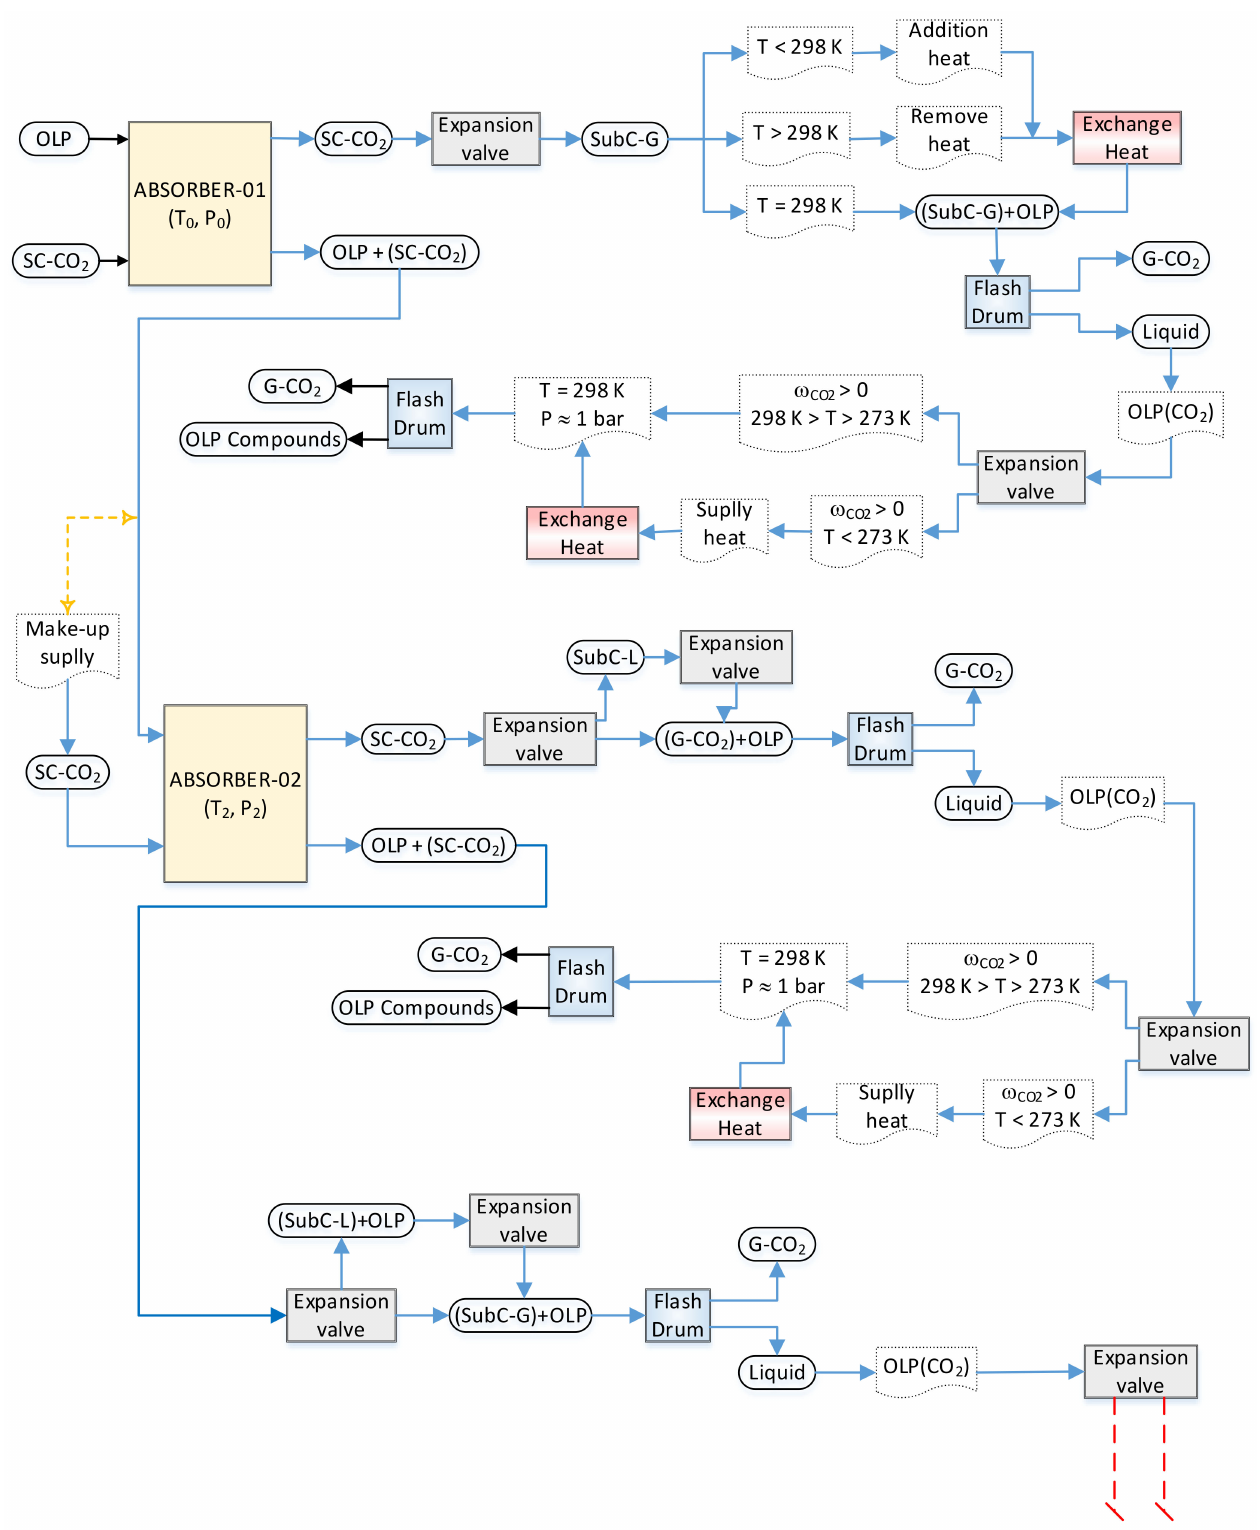
Figure 3. Flowsheet algorithm simulation strategy for the deacidification/deoxygenation of organic liquid products, obtained through the thermal catalytic cracking of palm oil at 450 ◦ C, 1.0 atm, with 10% (wt.) Na 2 CO 3 as a catalyst, in multistage countercurrent absorber columns using SC-CO 2 as a solvent, illustrating sub-flowsheet I with absorbers 01 and